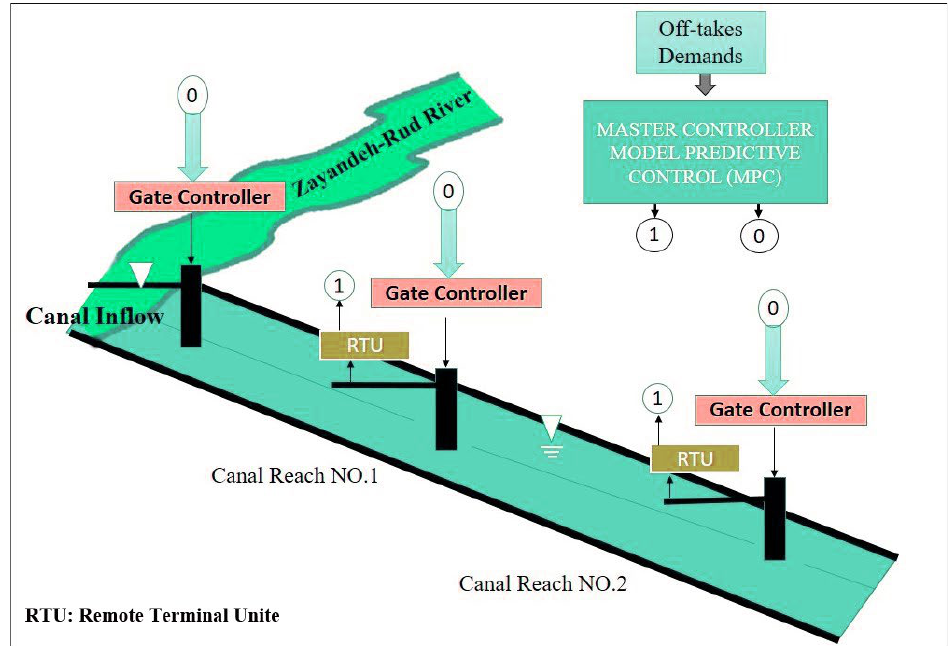
Figure 4. Centralized automatic operating system (note: 0: represents computing-controlled variable and 1: represents the hydraulic variable measured by sensors).